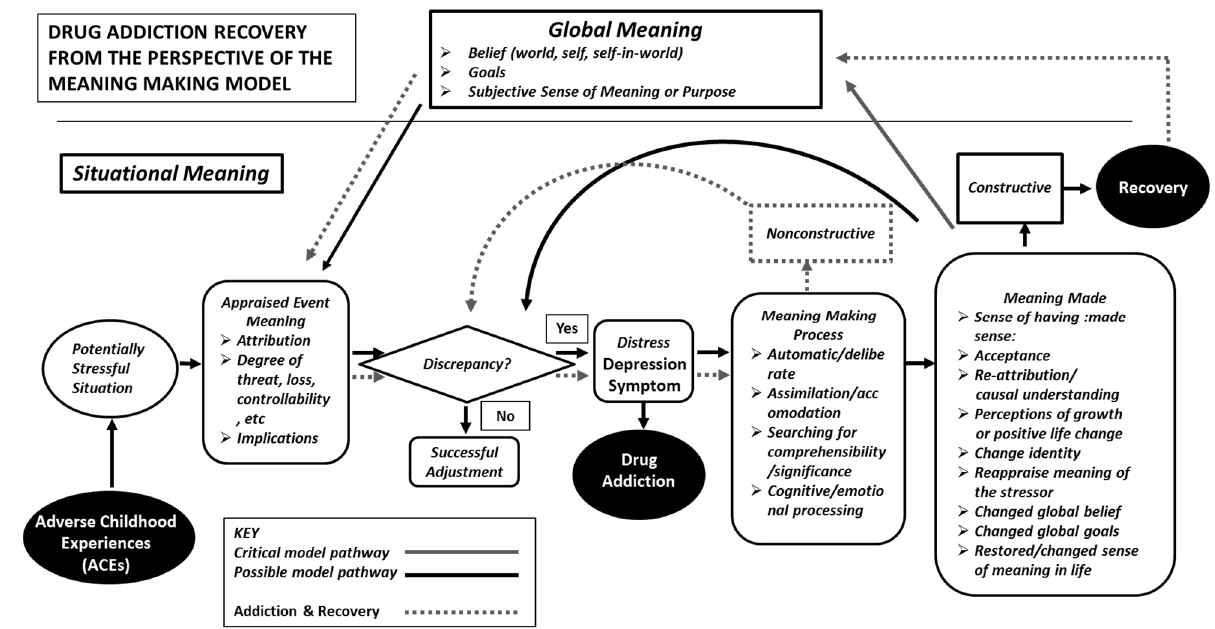
Figure 2. The meaning making model [17] in drug addiction recovery .